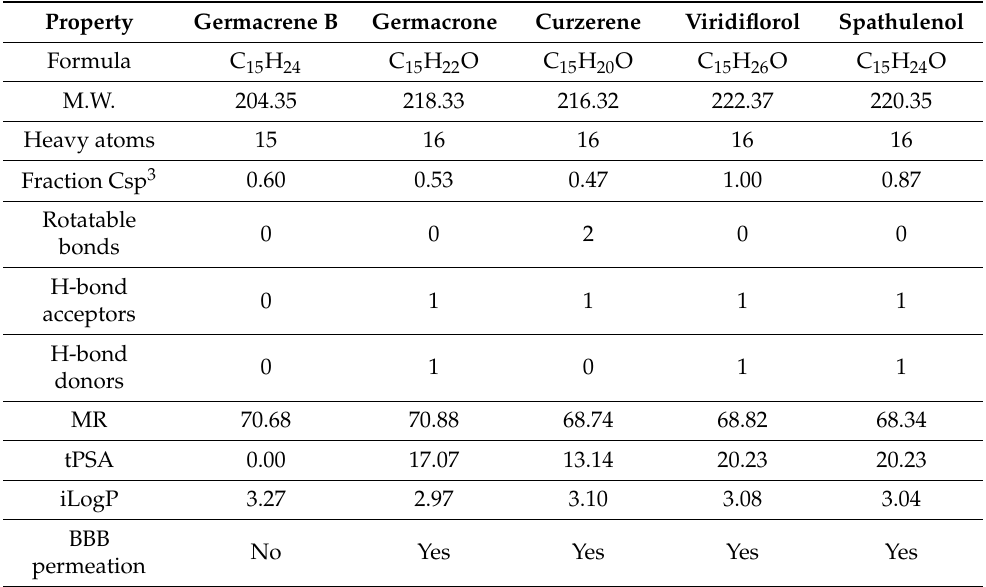
Table 7. Physicochemical properties of germacrene B, germacrone, curzerene, viridiflorol, and spathulenol according to SwissADME